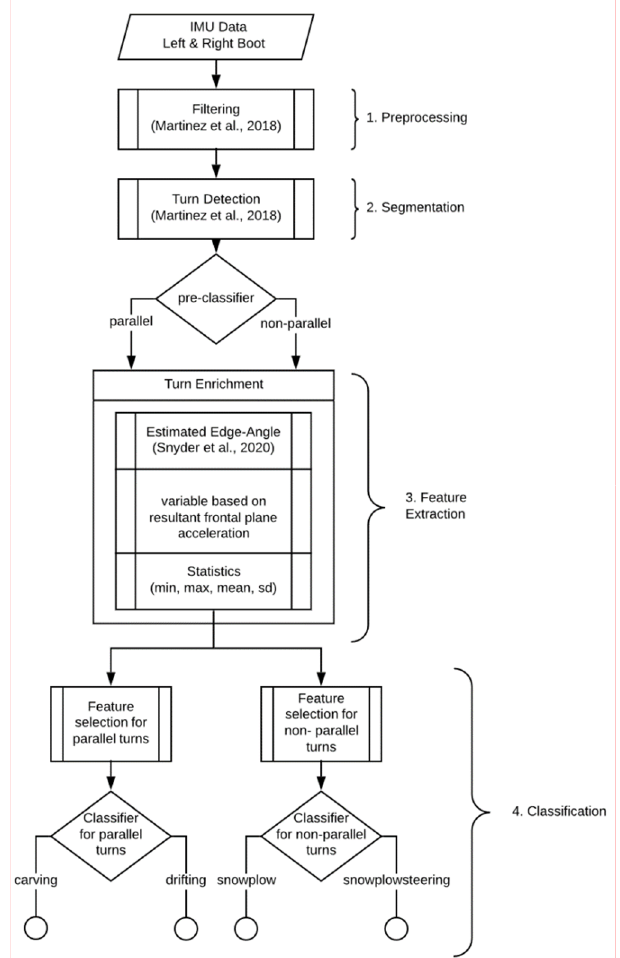
Figure 4. Flowchart from raw data to classification. Sensors 2020 , 20 , x FOR PEER REVIEW